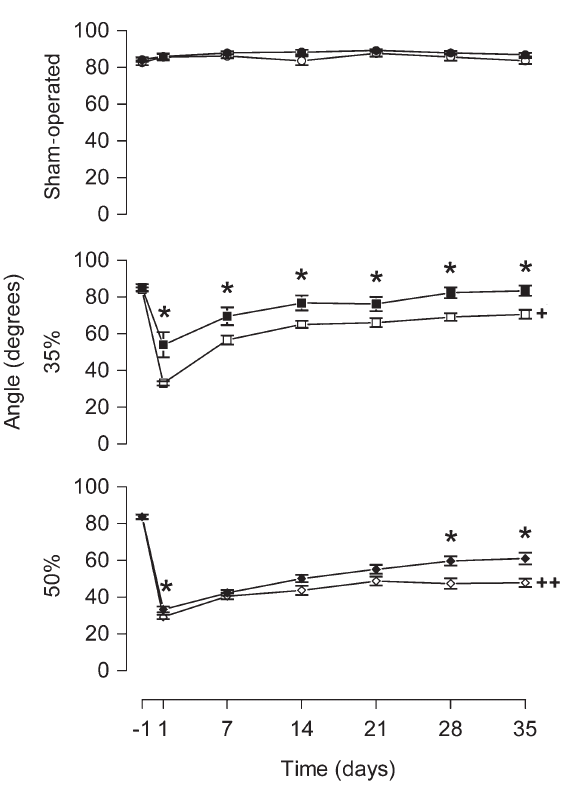
Figure 5. Melatonin treatment increased the angle on the inclined plane test. Results of the inclined plane test measured 24 h before (-1) and 1, 7, 14, 21, 28, and 35 days after narrowing of the spinal cord canal. Each point represents the mean ± SE for 9-11 rats. *P , 0.05 compared to the vehicle-treated group (indepen- dent Student t -test). + P , 0.0001 compared to sham-operated group from vehicle-treated animals, at all times after narrowing of the spinal cord canal (ANOVA with the Duncan post hoc test). ++ P , 0.0001 compared to sham-operated group at all times after narrowing of the spinal cord canal and ++ P , 0.05 compared to 35% narrowing, from vehicle-treated animals, on days 7, 14, 21, 28, and 35 after narrowing of the spinal cord canal (ANOVA with the Duncan post hoc test). 35% = 35% narrowing group; 50% = 50% narrowing group. Open symbols = vehicle- treated groups; filled symbols = melatonin-treated plane angle degree was observed (r = 0.95, r 2 = 0.90, P , 0.0001). BBB scores of 0, 7, 14, and 21 corresponded to approximately 23, 44, 65, and 86 degrees on the inclined plane, respectively.